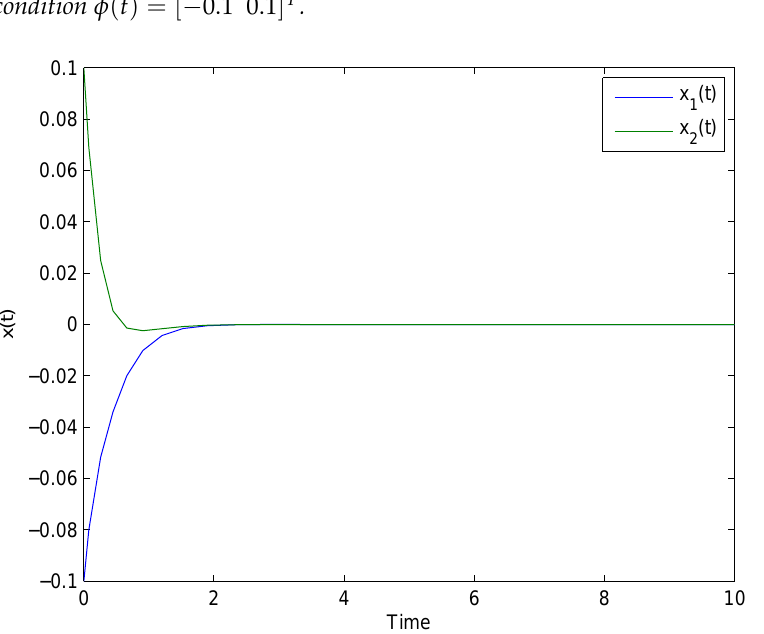
Figure 1. Response solution of the system (3) where w ( t ) = 0.